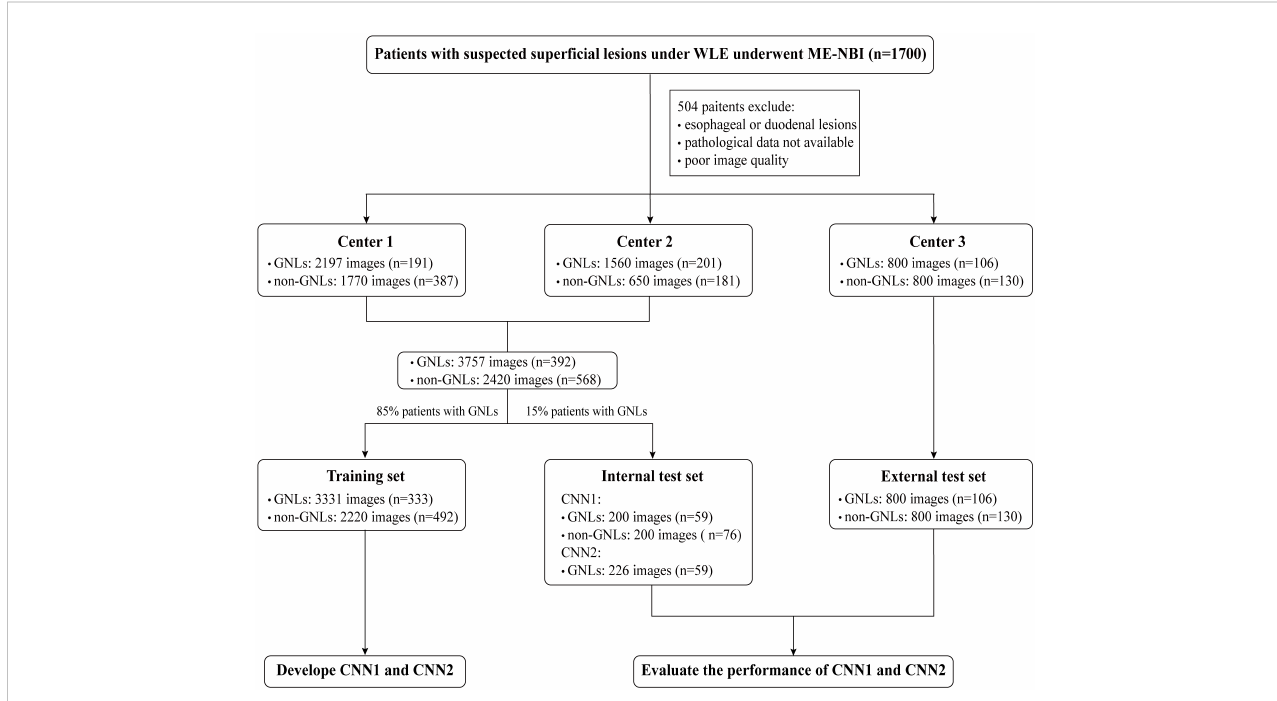
FIGURE 2 Flowchart of setting the datasets. WLE, white light endoscopy; ME-MBI, magnifying endoscopy with narrow band imaging; CNN, convolutional neural network; GNLs, gastric neoplastic